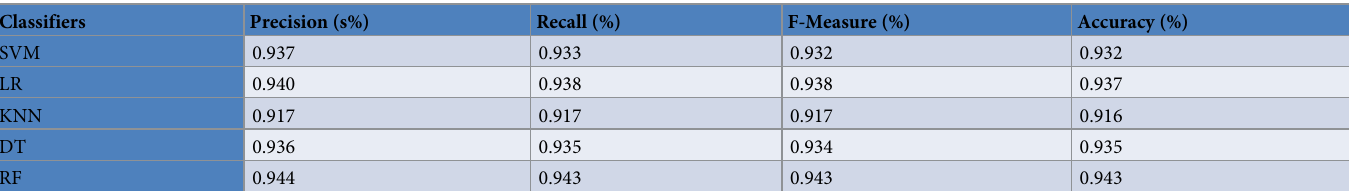
Table 11. Performance results attained on fused features using information